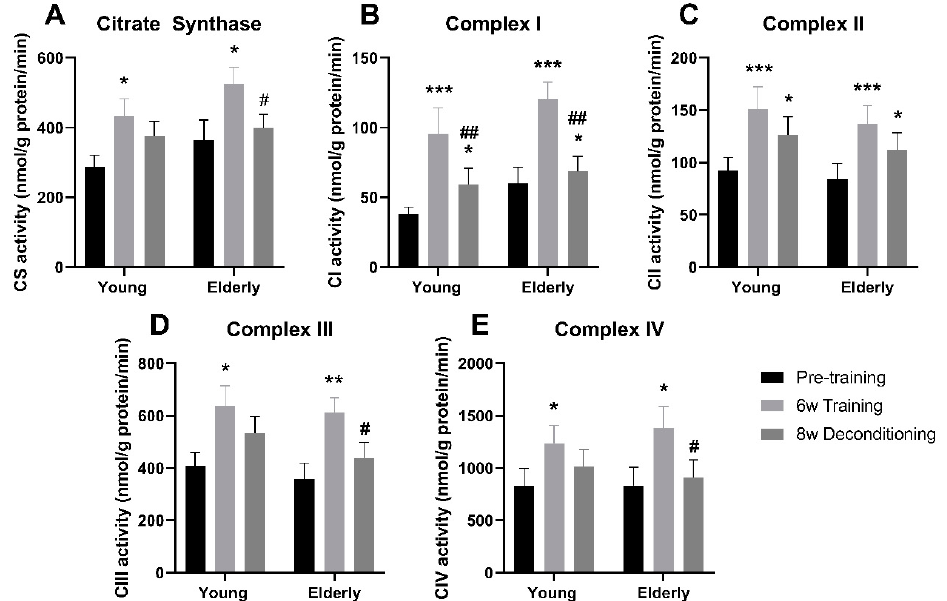
Figure 3. Mitochondrial enzyme activities. Maximal enzyme activity of citrate synthase (CS; A ), and mitochondrial complex I ( B ), II ( C ), III ( D ), and IV ( E ) in skeletal muscle pre and post six weeks of aerobic exercise training and after subsequent 8 weeks of deconditioning in young and elderly individuals. n = 10 in young group and n = 11 in the elderly group. */**/*** p < 0.05/0.01/0.001, significantly different from pretraining within age group. #,## significantly different from 6 weeks of training within age group.